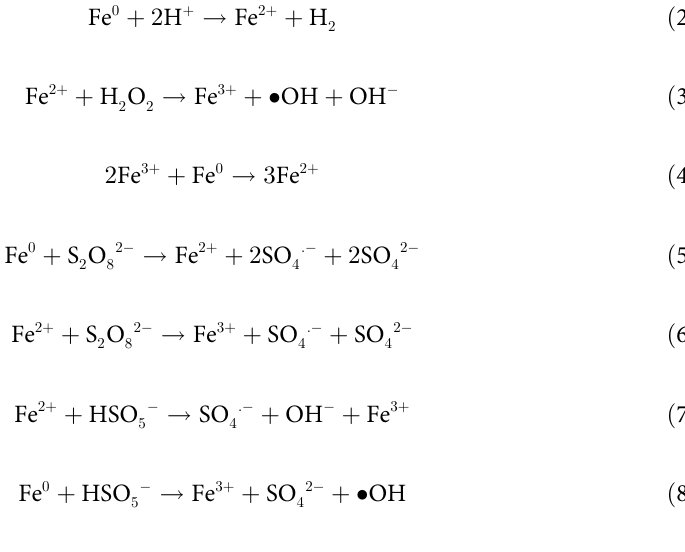
increasing mass of added ZVI. When 0.02 to 0.2 g/L ZVI was used, 2,4,6-TCP degradation pro- ceeded in a gradual and sustained manner in the Fe 0 /H degradation ratio increased with an increasing iron dose in the Fe 0 /peroxide systems. Fe 0 can generate dissolved Fe 2+ , which can also activate peroxides in acidic conditions (Eqs 2–8). When 0.2 g/L Fe 0 was used, the 2,4,6-TCP oxidation rates were all over 80% in the Fe 0 /H and Fe 0 /PMS systems, and a 37% 2,4,6-TCP degradation ratio was found in the Fe 0 /PS system. However, without the presence of peroxides, ZVI could hardly decompose 2,4,6-TCP.